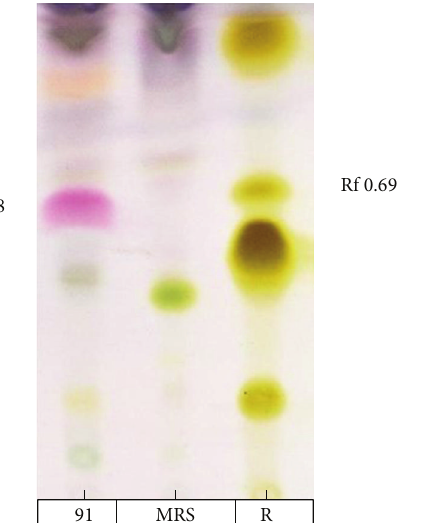
Figure 2: Glycolipid stained with postchromogenic compound (anisaldehyde solution).